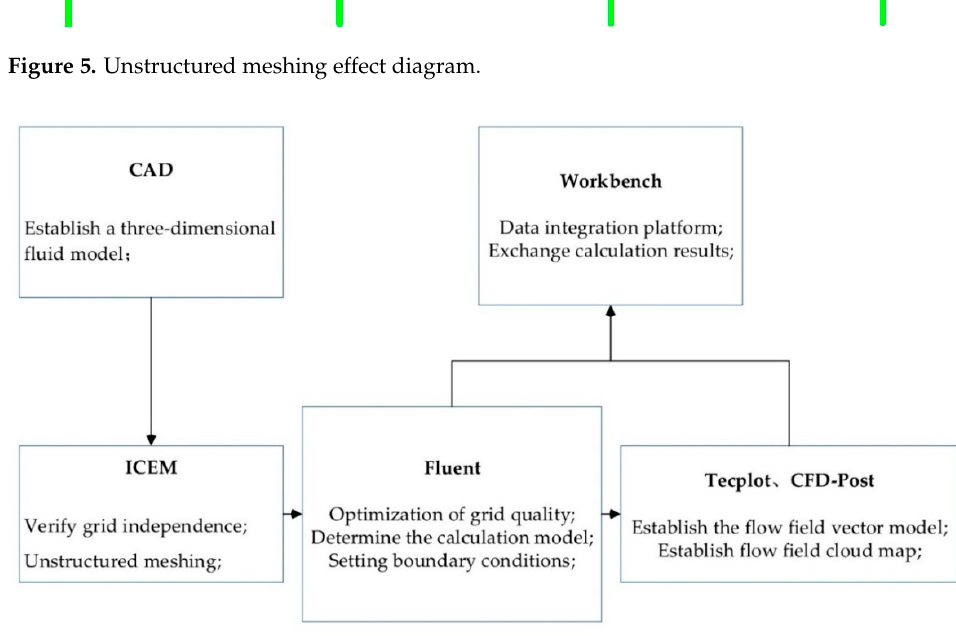
Figure 6. Calculation model establishment process.